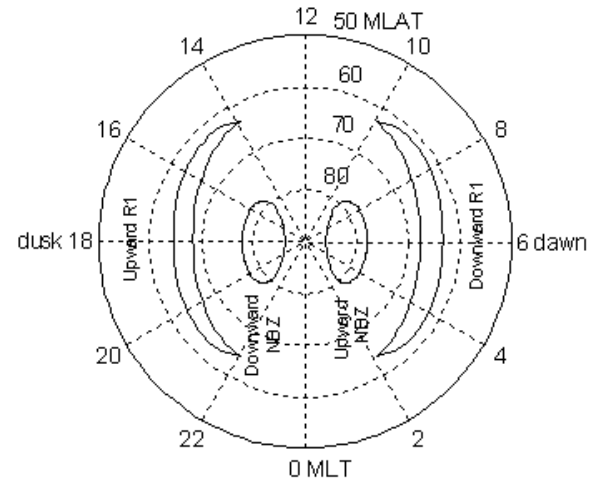
Fig. 1. Cartoon of the typical distribution of the NBZ and R1 FACs for positive IMF B z